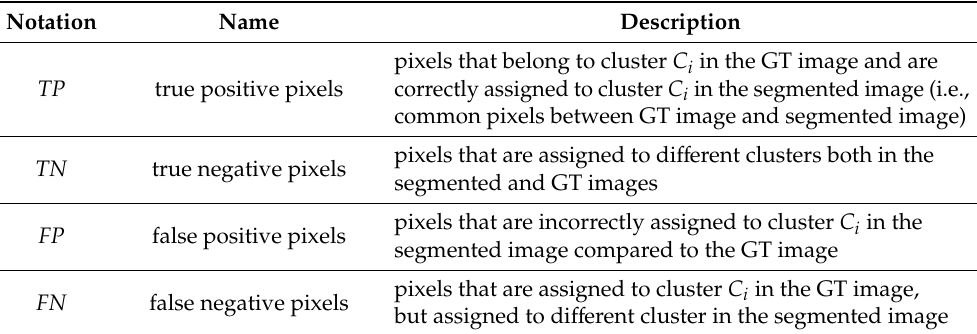
Table 3. Notation for the external comparison